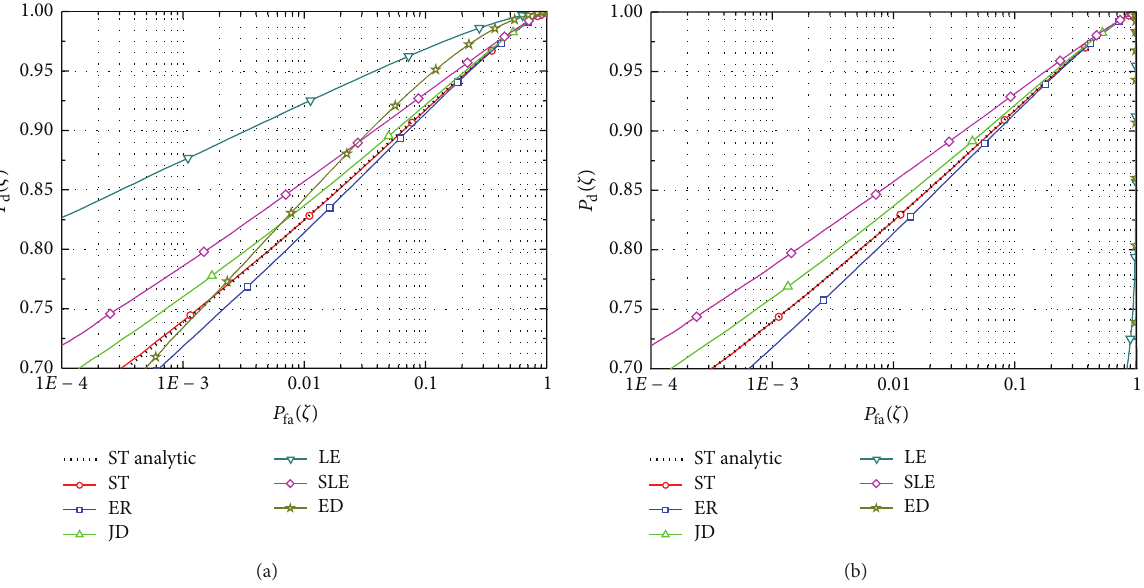
Figure 12: ROCs over a Rayleigh fading channel, for 𝐾 = 4, 𝑁 = 400, 𝑃 = 1, and SNR 1 = − 3dB, with 𝜇 = 0dB (a) and 𝜇 = 0 . 5 dB (b) for the LE and the